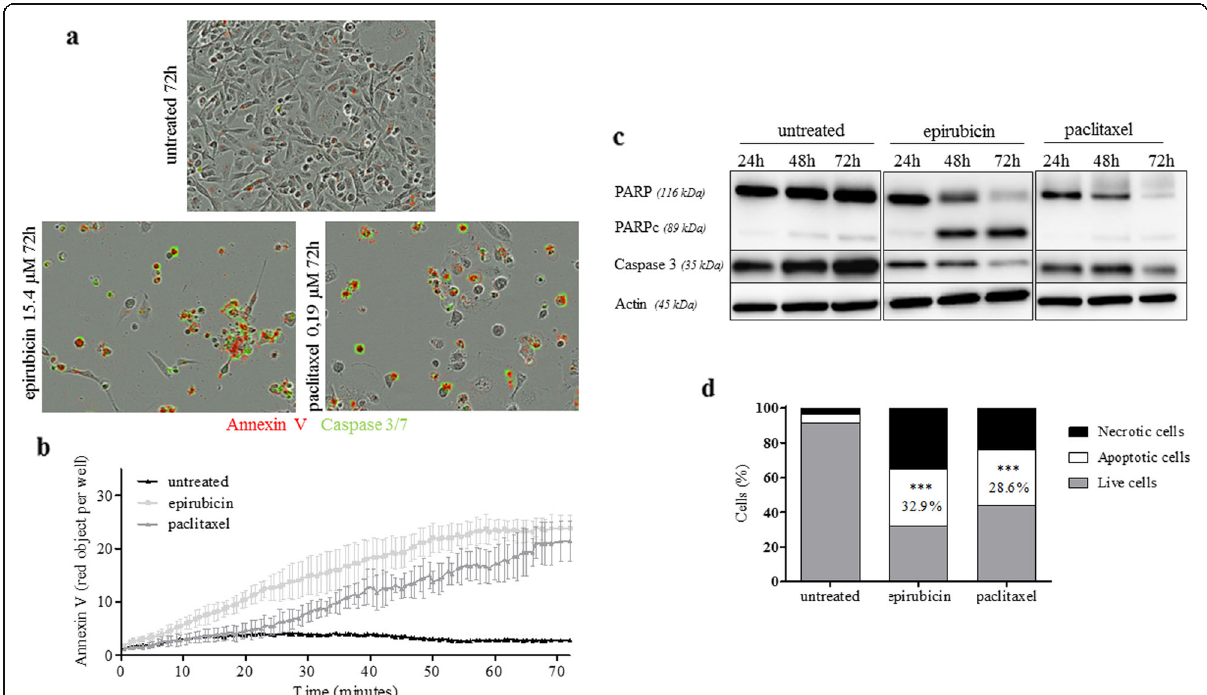
Fig. 2 Apoptotic induction after treatment by epirubicin or paclitaxel in MDA-MB-231 cells. a Time-lapse images detection of apoptosis in MDA- MB-231 cells in the presence of Caspase-3/7 Green Apoptosis reagent and Annexin V Red Reagent. b Percent of apoptotic cells with high annexin V reagent was assessed in time-lapse imaging (IncuCyte) over 72 h. c Western blot analysis showing the cleavage of PARP and Caspase 3 decrease. Actin was used as a loading control. d Quantitative analysis of apoptotic cells measured by flow cytometry in untreated, epirubicin- treated, or paclitaxel-treated MDA-MB-231 cells for 72 h. ( n = 3 independent experiments; mean ± SD). Compared to untreated, *** p < 0.001 (Mann-Whitney